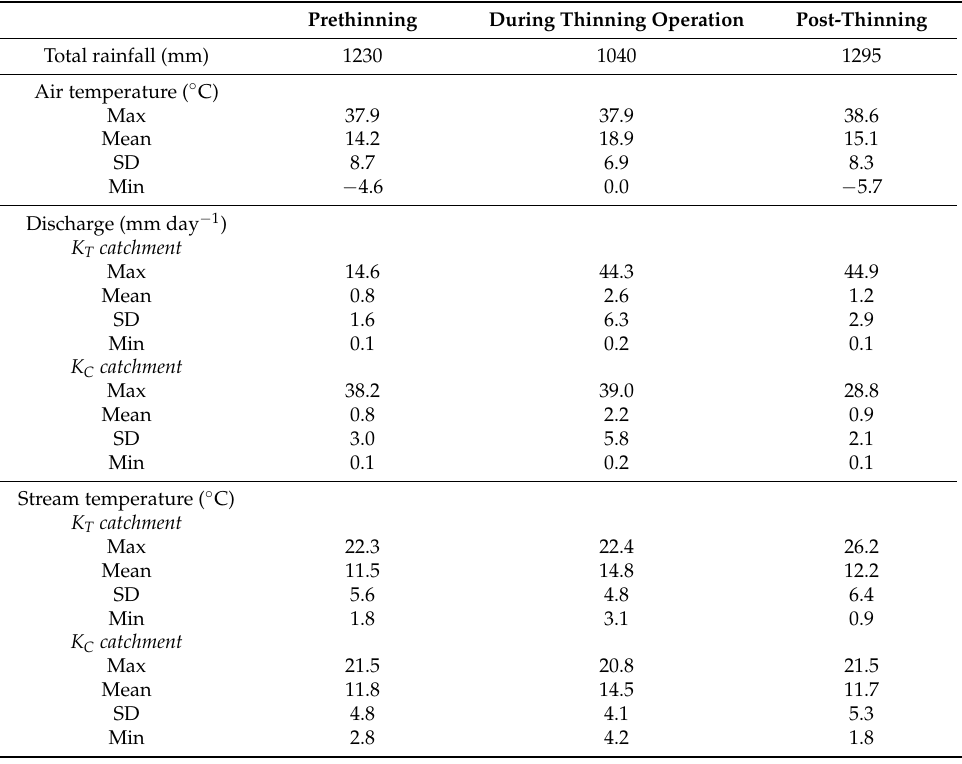
Table 1. Summary of air temperature, stream discharge, and stream